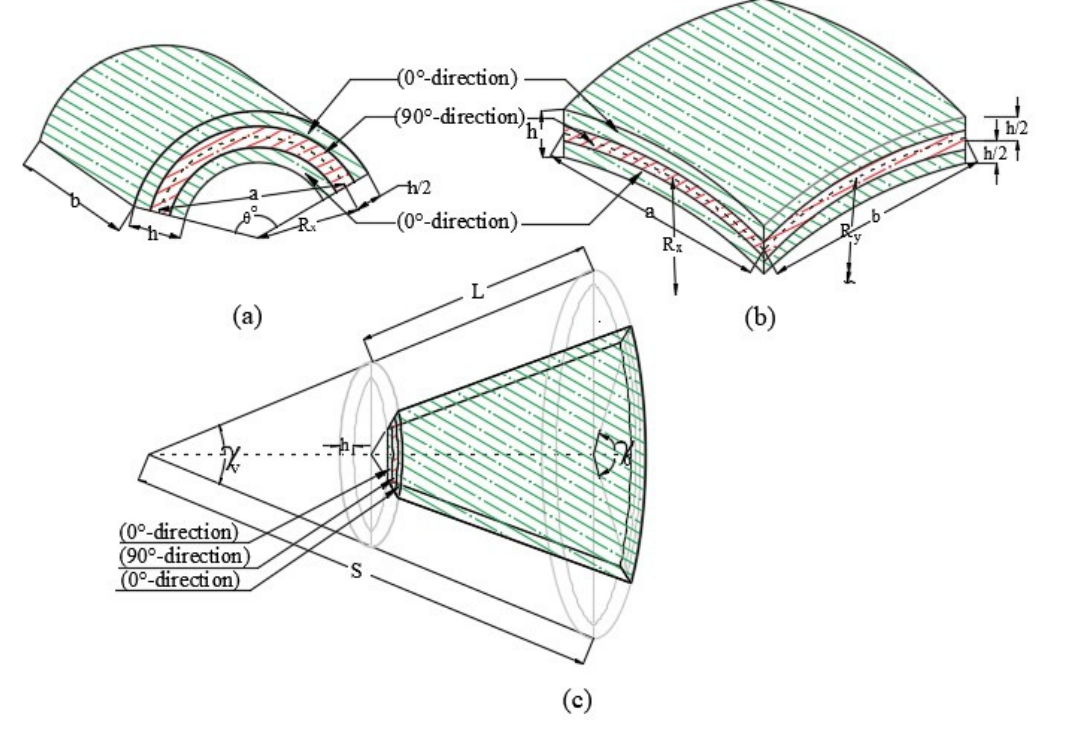
Figure 1: Geometry of the composite cylindrical (a), spherical (b) and conical (c) shell